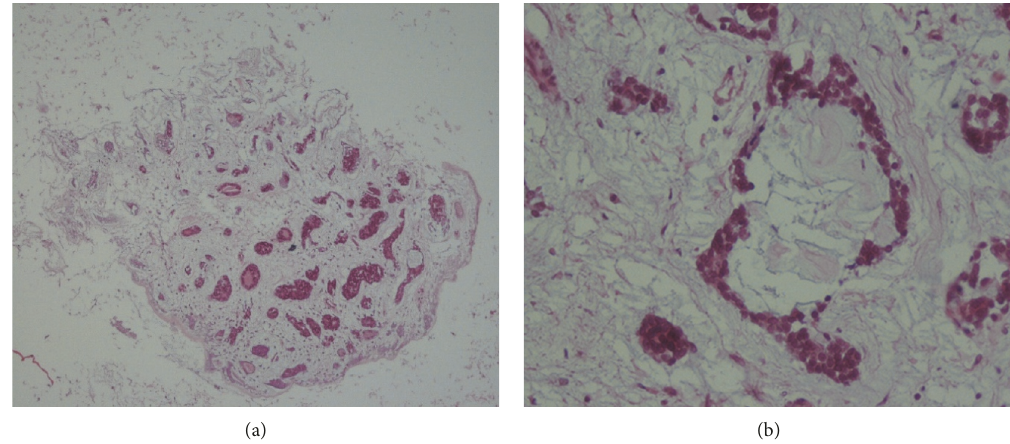
Figure 2: Cell block slide. (a) Tubular-like structure and cribriform pattern with acidophilic materials (H&E stain, × 100). (b) Small nests and strands of tumor cells (H&E stain, × 400).